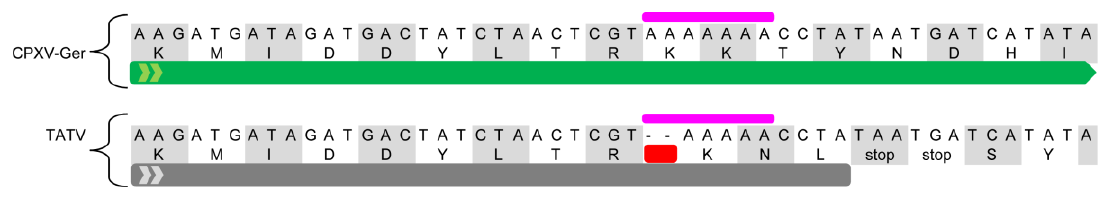
Figure 2. Example of an early stop mutation (ESM) overlapping a microsatellite. For each isolate, a portion of the coding sequence for the thymidylate kinase gene (Cop-A48R) is shown. The top row is the nucleotide sequence, the amino acid translation is the middle row, and a bar is shown to indicate the gene ORF. The green bar represents the intact gene in CPXV-Ger which continues off the right of the figure, and the grey bar represents the homologous truncated gene in TATV. The pink bars highlight microsatellites consisting of a monomeric repeat. An ESM in TATV in the form of a 2 bp deletion is shown by the red bar.